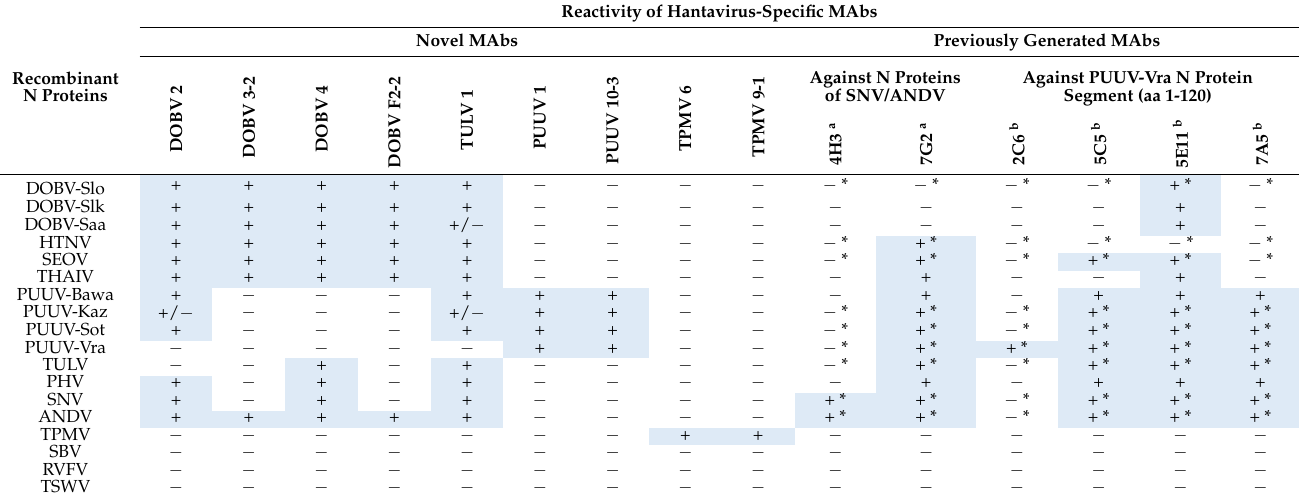
Table 3. Reactivity patterns of hantavirus-specific MAbs with hantavirus N proteins and control proteins in Western blot